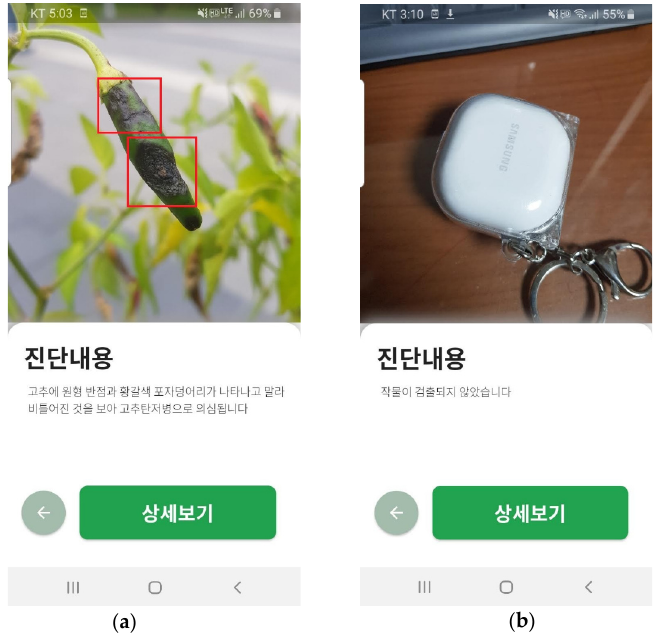
Figure 18. ( a ) The output of the red pepper with Anthracnose below 진단내용 (Diagnosis) ; ( b ) The output of non ‐ crop image below 진단내용 (Diagnosis).